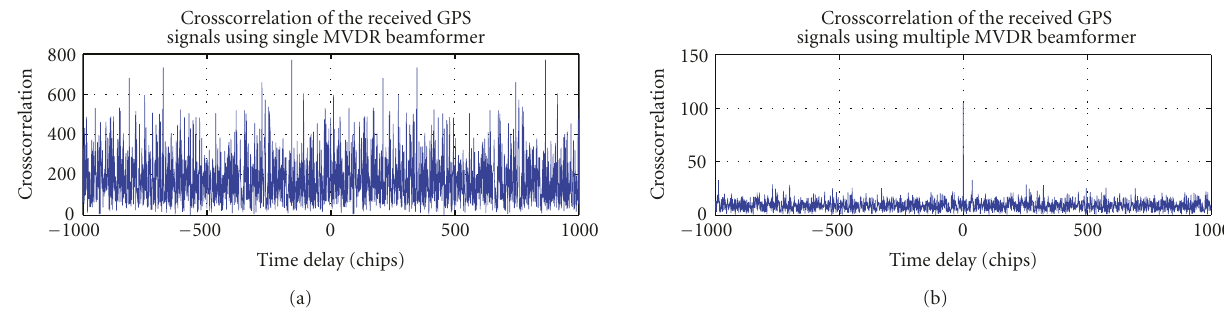
Figure 4: Cross-correlation of the received GPS for single and the first beamformer of the multiple MVDR beamformers with four RHCP